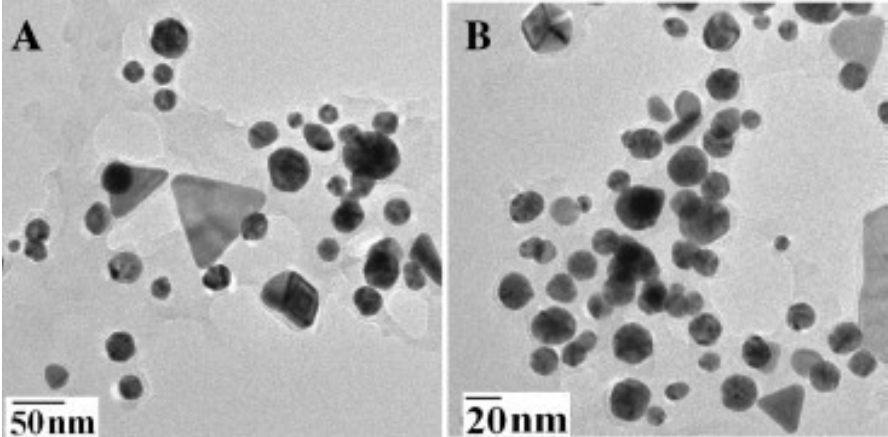
Figure 6. ( A , B ) TEM images of AuNPs synthesized by leaf extract of coriander. Reprinted with permission from Ref. [76]. Copyright 2008